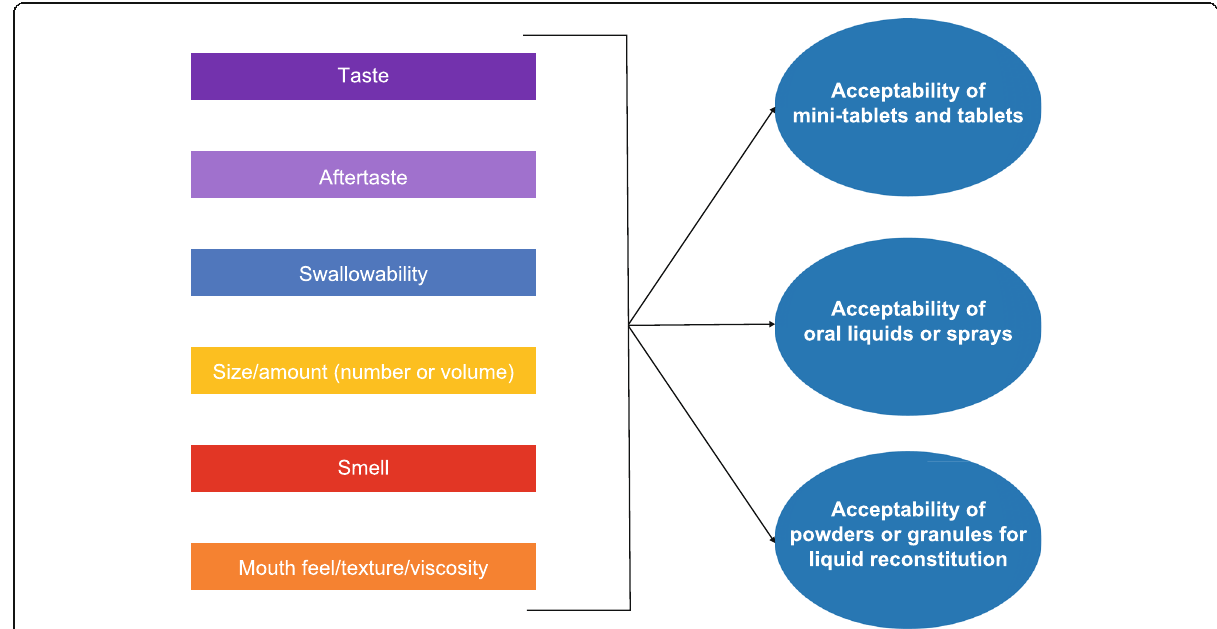
Fig. 3 Final conceptual model of targeted oral formulation key acceptability attributes following patient and caregiver interviews